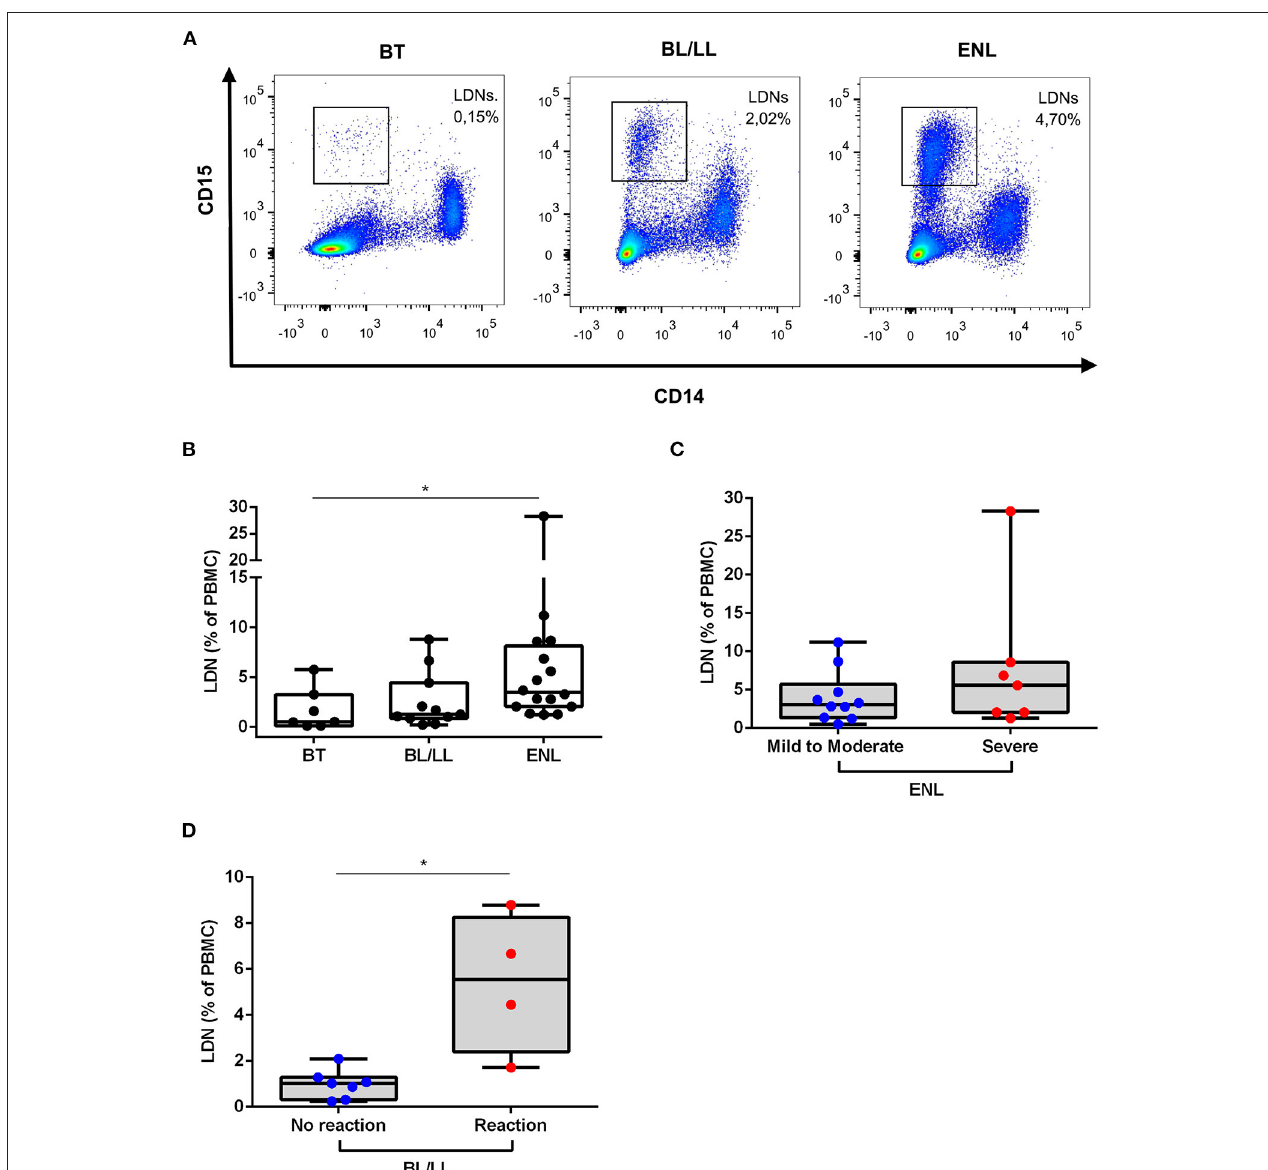
FIGURE 2 | Low-density neutrophils are elevated in ENL patients. (A) Representative flow cytometric analysis of low-density neutrophils (LDNs) in peripheral blood mononuclear cells (PBMCs) of BT, BL/LL, and ENL patients. LDNs were gated within the PBMCs as CD14 − CD15 + cells. (B) Frequency of LDNs in the PBMC layer of BT ( n = 7), BL/LL ( n = 11), and ENL patients ( n = 16). (C) Frequency of LDNs in the PBMC layer of ENL patients classified with mild-to-moderate ( n = 9) and severe ENL ( n = 7) according to the ENList scale. (D) Frequency of LDNs on the PBMC layer of BL/LL patients who did not develop reaction ( n = 7) and BL/LL patients who developed any type of leprosy reaction up to one year after the analyses ( n = 4). Borderline tuberculoid (BT), borderline lepromatous/lepromatous leprosy (BL/LL), and erythema nodosum leprosum patients (ENL). Box plots show median, interquartile range, and sample minimum and maximum. Dots represent individual patients. Statistic: (B) Kruskal–Wallis with Dunn’s post-test and (C,D) Mann–Whitney. * p <